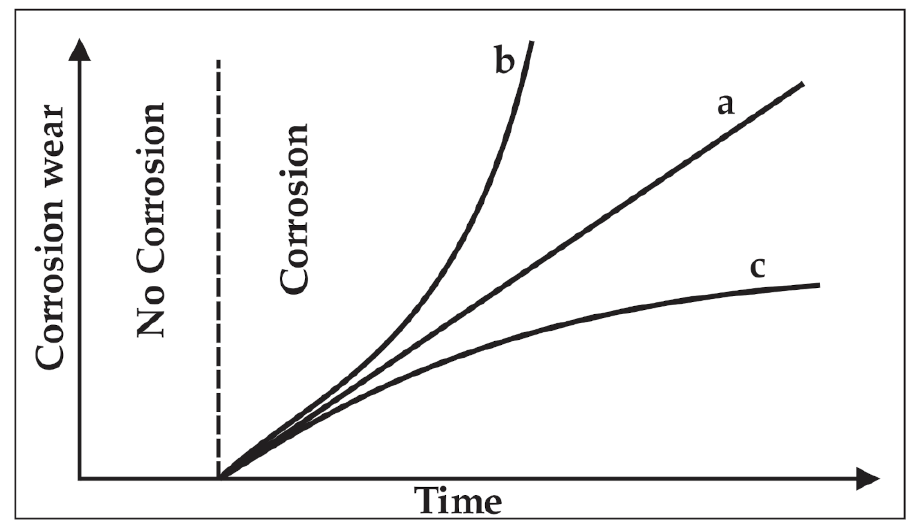
Figure 1. General model of corrosion